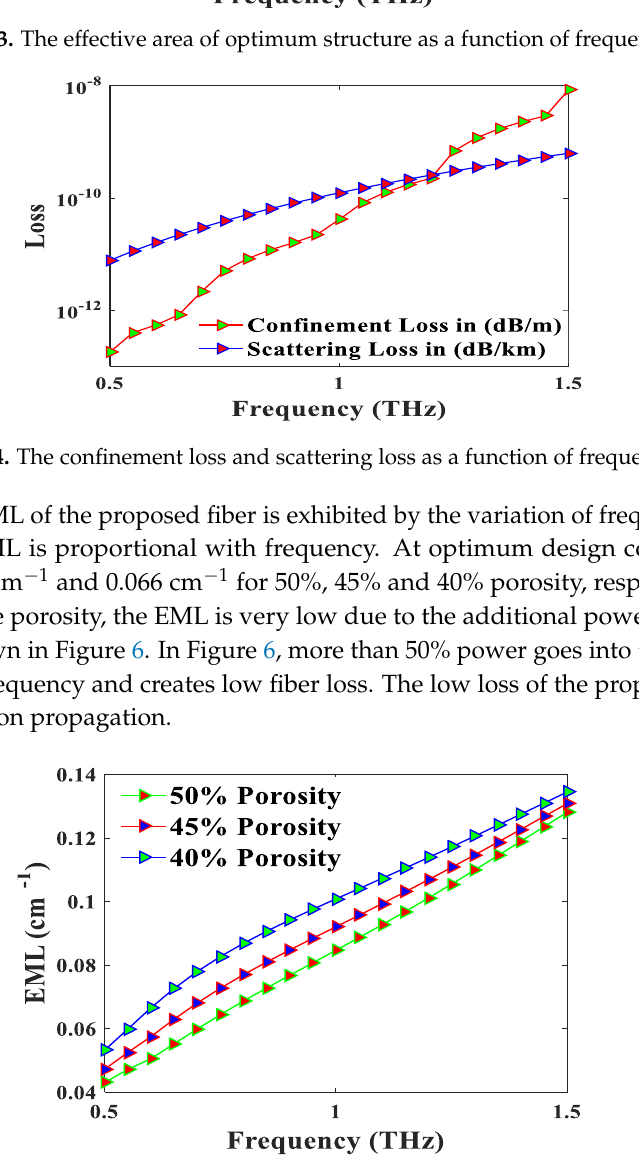
Figure 5. The effective material loss (EML) as a function of frequency for different